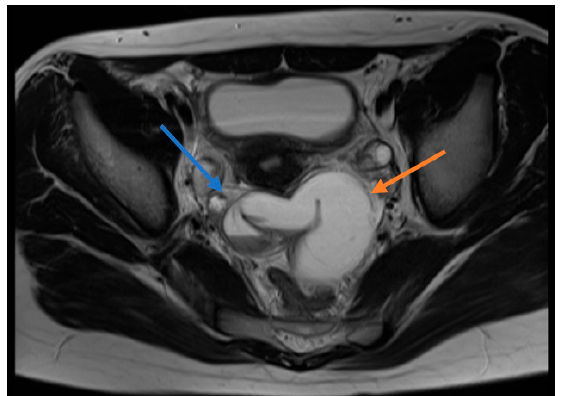
Figure 1. Magnetic resonance image (MRI) of a patient diagnosed with preoperative isolated fallopian tube torsion. T1A sections show blue arrow torsion, red arrow indicates hydrohematosalpinx.